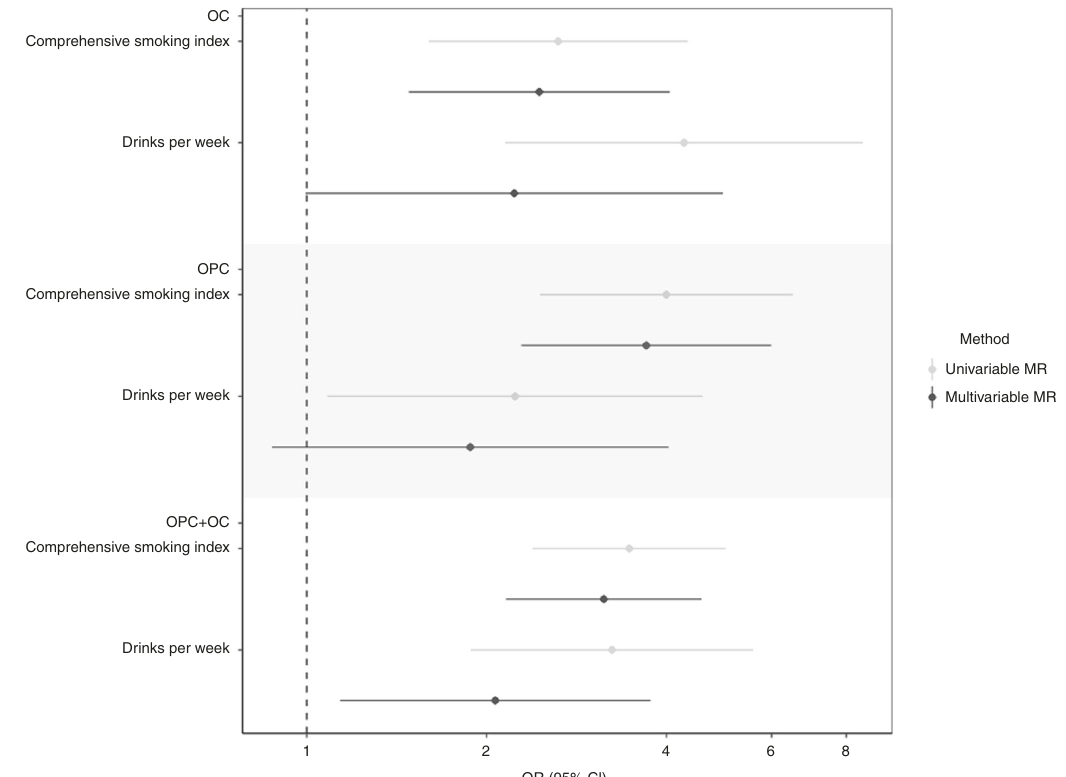
Fig. 3 Multivariable Mendelian randomisation of lifetime smoke exposure and drinks per week on oral and oropharyngeal subsites. Effect estimates (ORs) are reported per SD increase in the exposure of drinks per week ( n = 226,223) and the comprehensive smoking index ( n = 226,223) on oral and oropharyngeal cancer risk ( n = 6034 cases and 6585 controls). Error bars represent 95% con fi dence intervals. Genetic instrument for drinks per week excludes outlying variant, ADH1B (rs1229984). Univariable and multivariable effects displayed were obtained using summary-level data from the GWAS of comprehensive smoking index in UK Biobank and summary-level data from a GWAS of drinks per week in GSCAN, excluding UK Biobank and 23andMe. All statistical tests were two-sided.